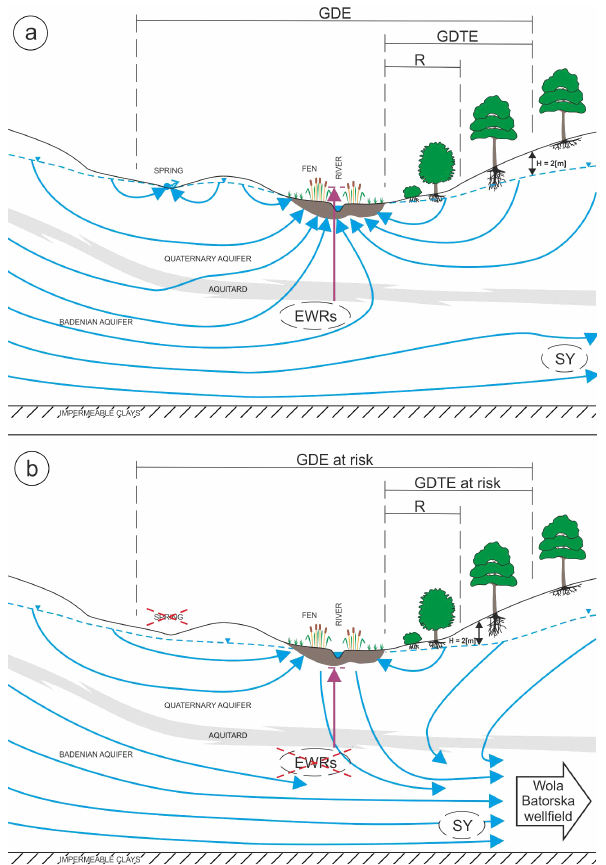
Figure 3. Conceptual model of the Wielkie Błoto fen. (a) Natu- ral state; (b) envisaged future status as a result of intense exploita- tion of the Wola Batorska well field. GDE – groundwater-dependent ecosystem; GDTE – groundwater-dependent terrestrial ecosystem; R – riparian forest; EWRs – environmental water requirements; SY – safe yield of the aquifer exploited by the Wola Batorska well